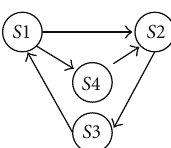
Figure 21: Wireless sensor network.